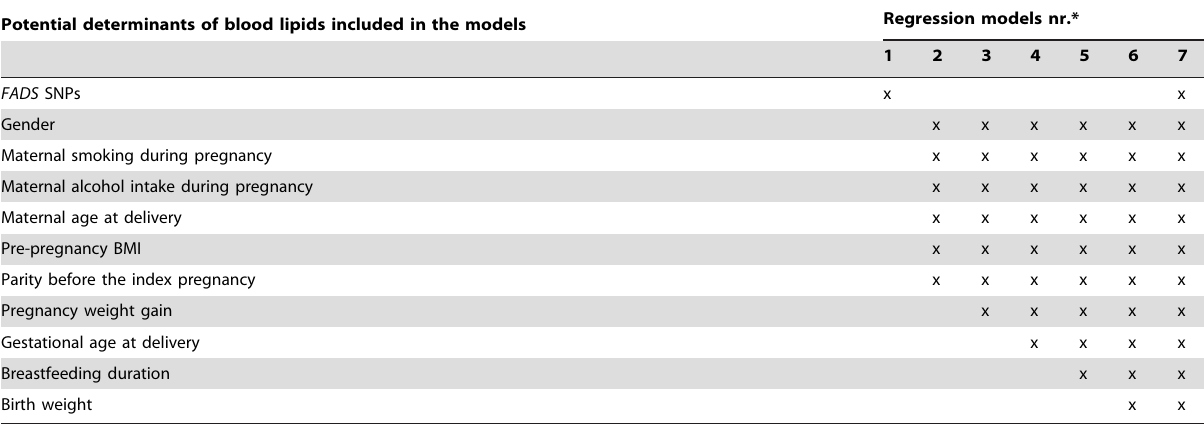
Potential determinants of blood lipids included in the models Regression models nr.*